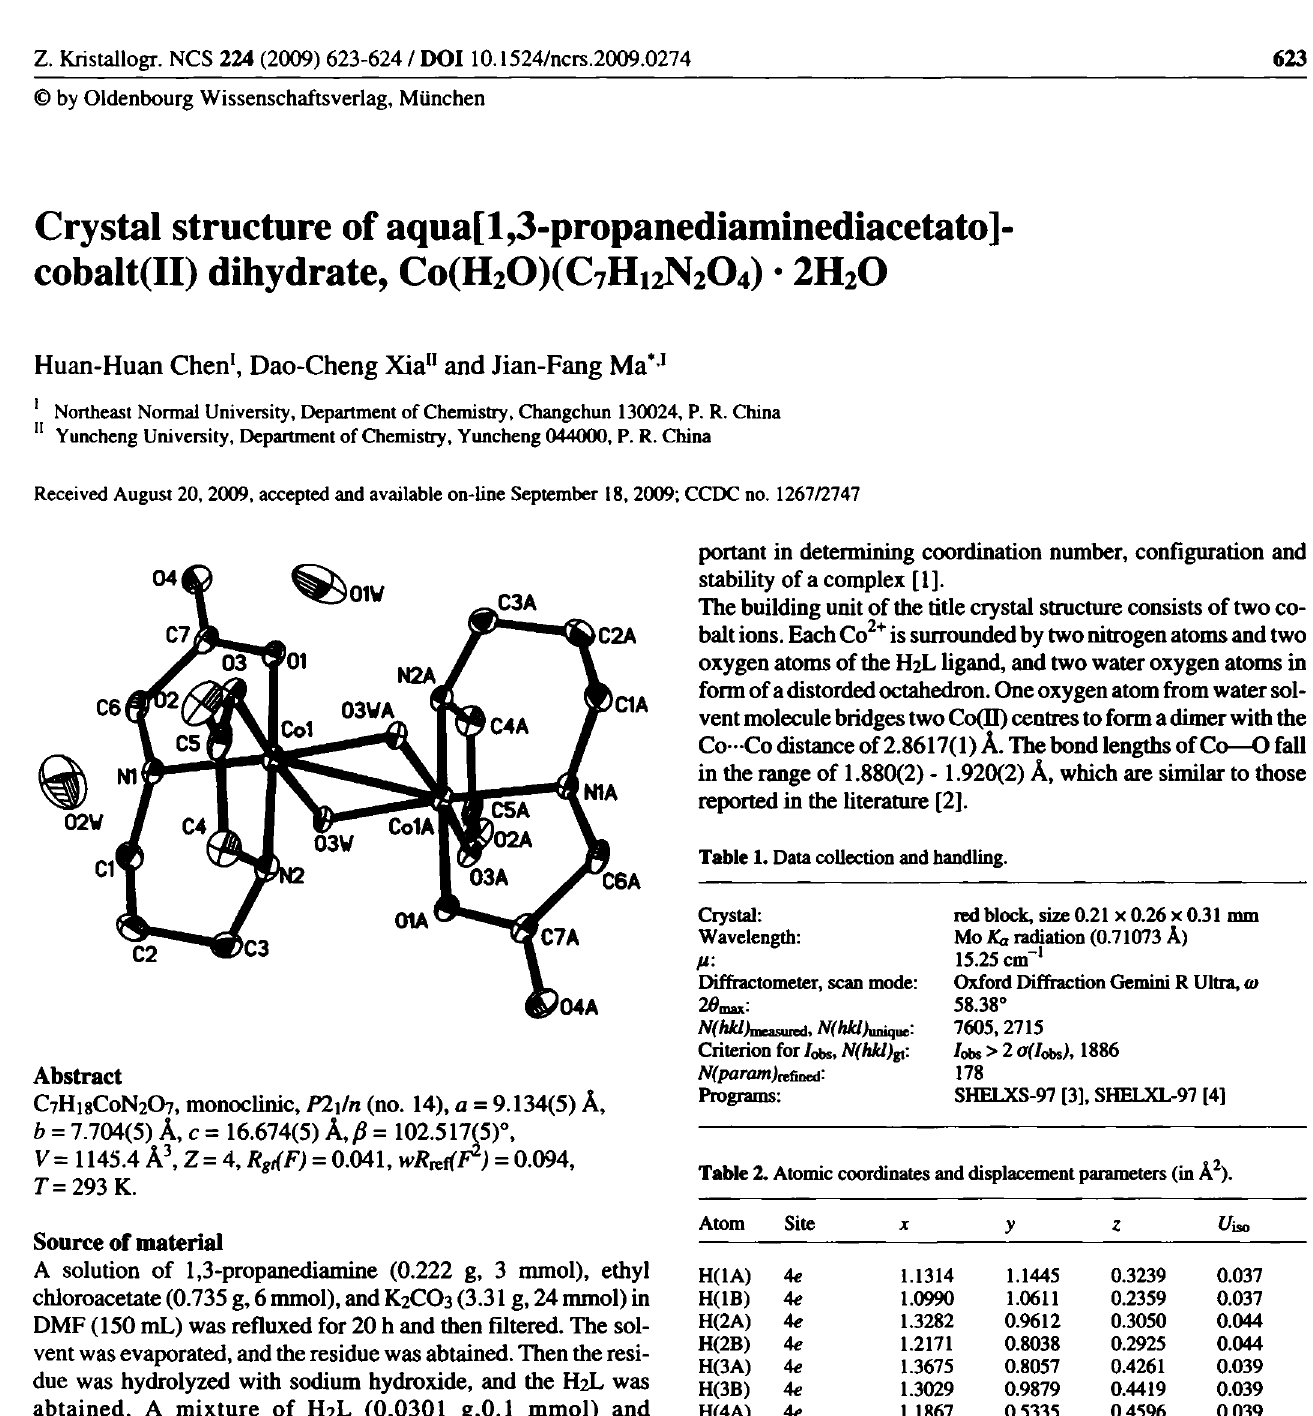
Table 2. Atomic coordinates and displacement parameters (in Â 2